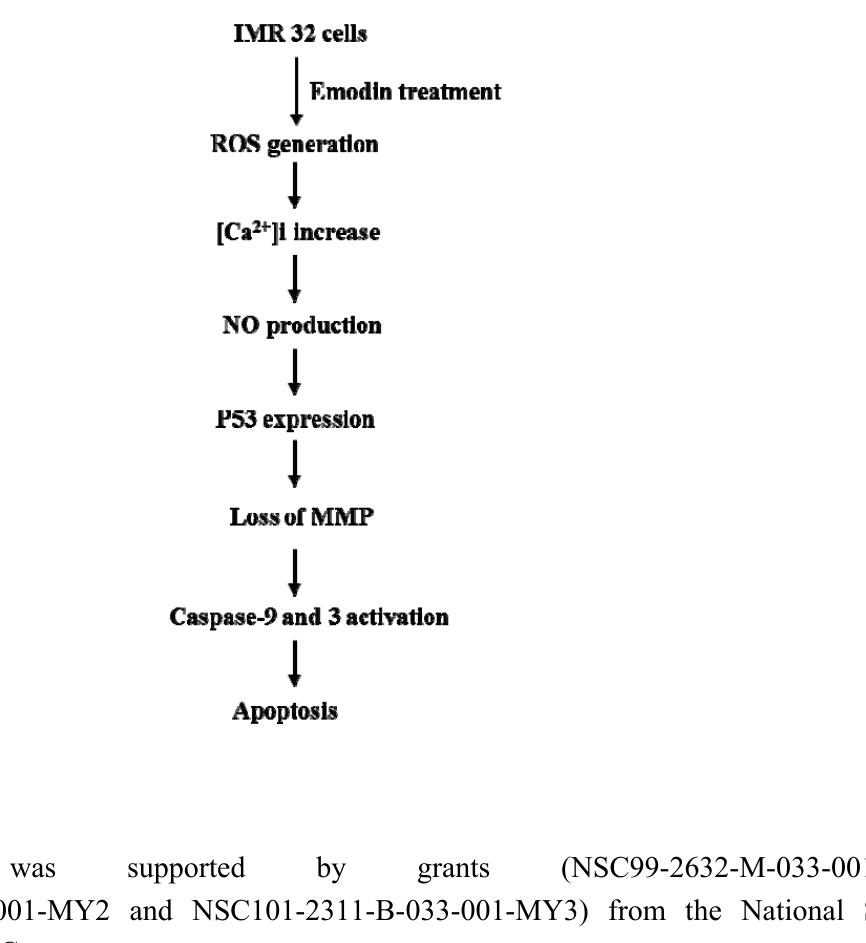
Figure 7. Summary of events occurring during emodin-induced apoptosis in IMR32